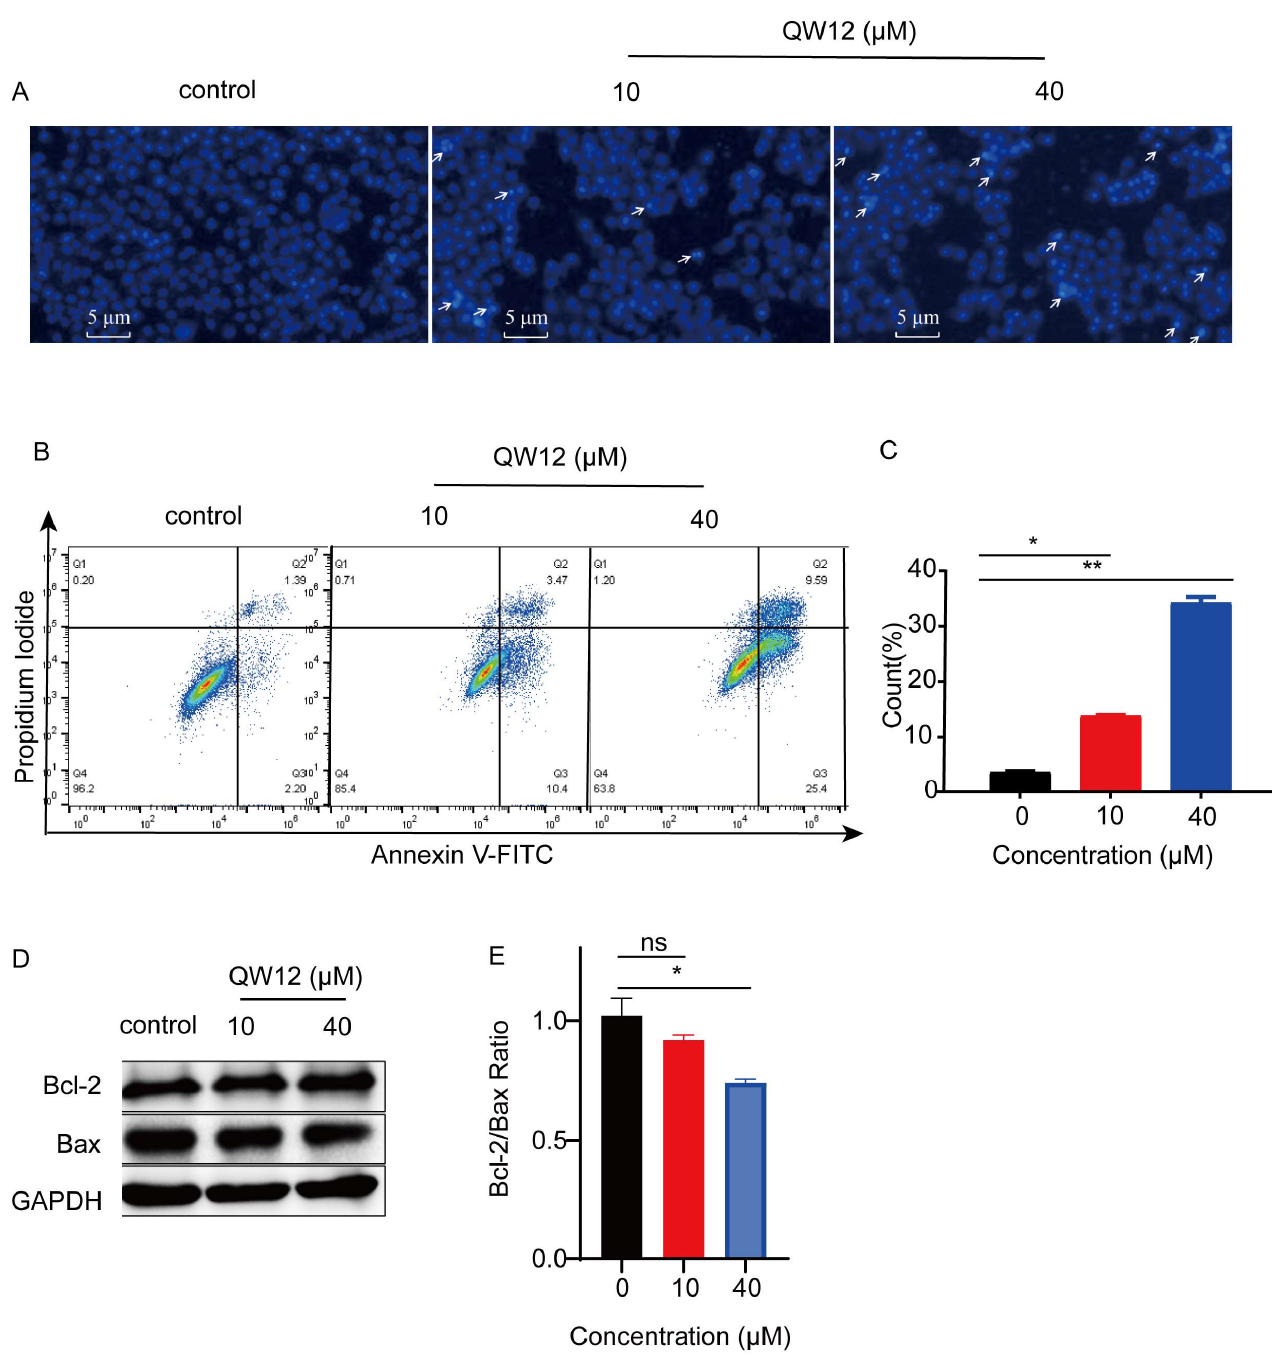
Figure 6. QW12 induces HeLa cell apoptosis. ( A ) The effect of QW12 on the nuclear morphology of HeLa cells after 24 h treatment was detected by Hoechst-33342 staining. Apoptotic bodies are indicated by white arrows. ( B ) The concentration-dependent induction of apoptosis in HeLa cells by QW12 . ( C ) Quantitative statistics of the results in ( B ) using the GraphPad software. ( D ) Bcl-2 and Bax Levels after treatment with compound QW12 (10, 40 μM) for 24 h. GAPDH was used as a control. ( E ) Quantitative statistics of the results in ( D ) using GraphPad software. Values are presented as means ± SD of three independent experiments. n/s is not significant, * p < 0.1, ** p < 0.01.